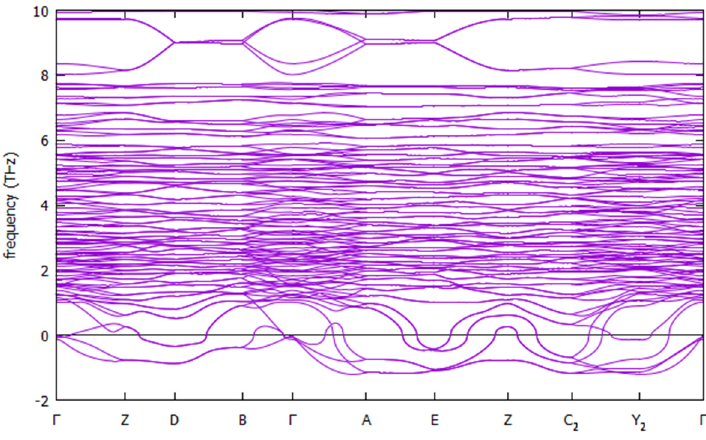
Figure 3. [Trz]Cu(H 2 POO) 3 phonon band structure (THz) for high-symmetry directions of the Brillouin zone.